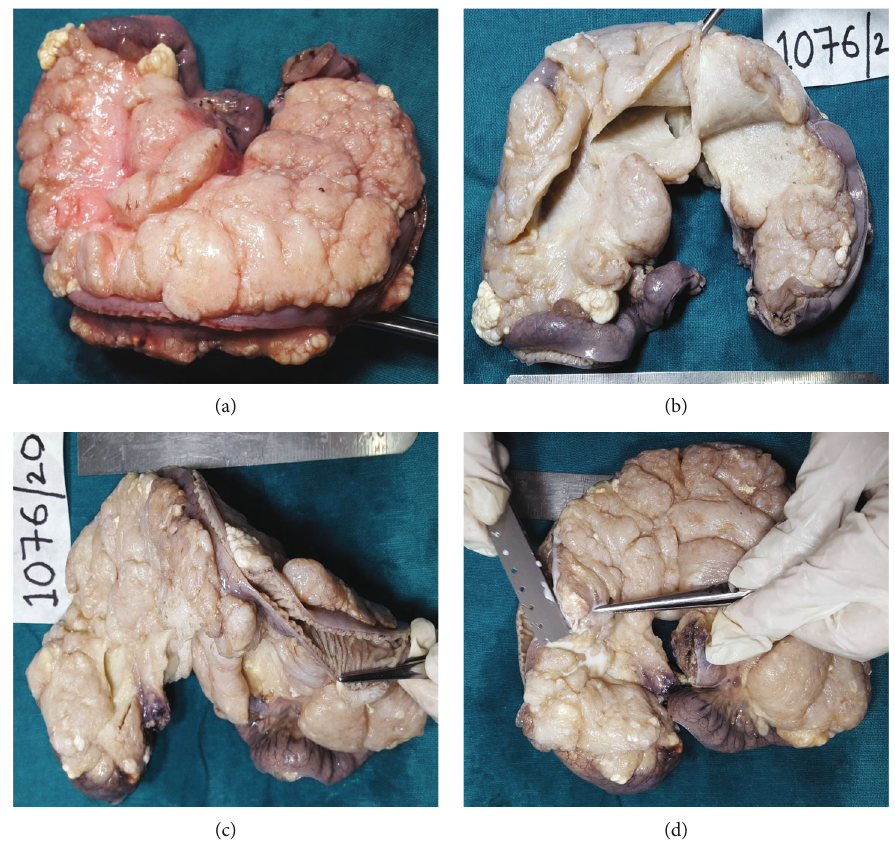
Figure 2: Gross photograph of mesenteric lymphangioma of small intestine: (a) postoperative specimen. (b) Formalin- fi xed specimen with section through the mass showing pale white solid tan to spongy appearances, (c) involvement of small intestine, and (d) oozing of the milky fl